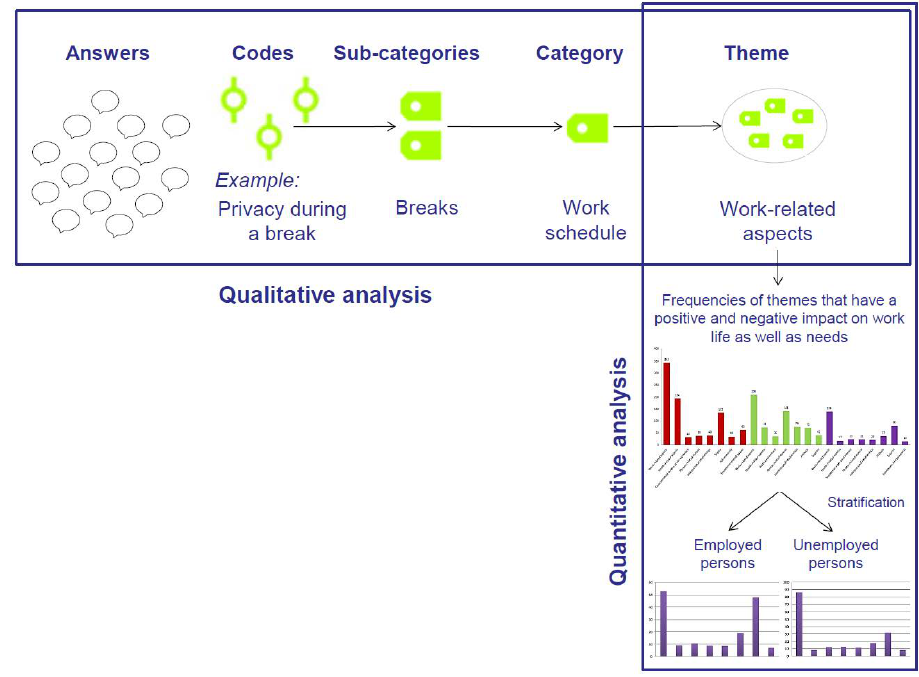
Figure 1. Scheme of qualitative and quantitative analysis; an example of the data analysis.